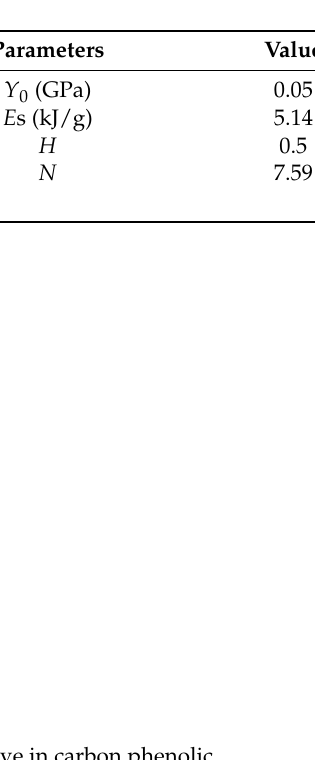
Table 3. Material parameters of carbon phenolic.